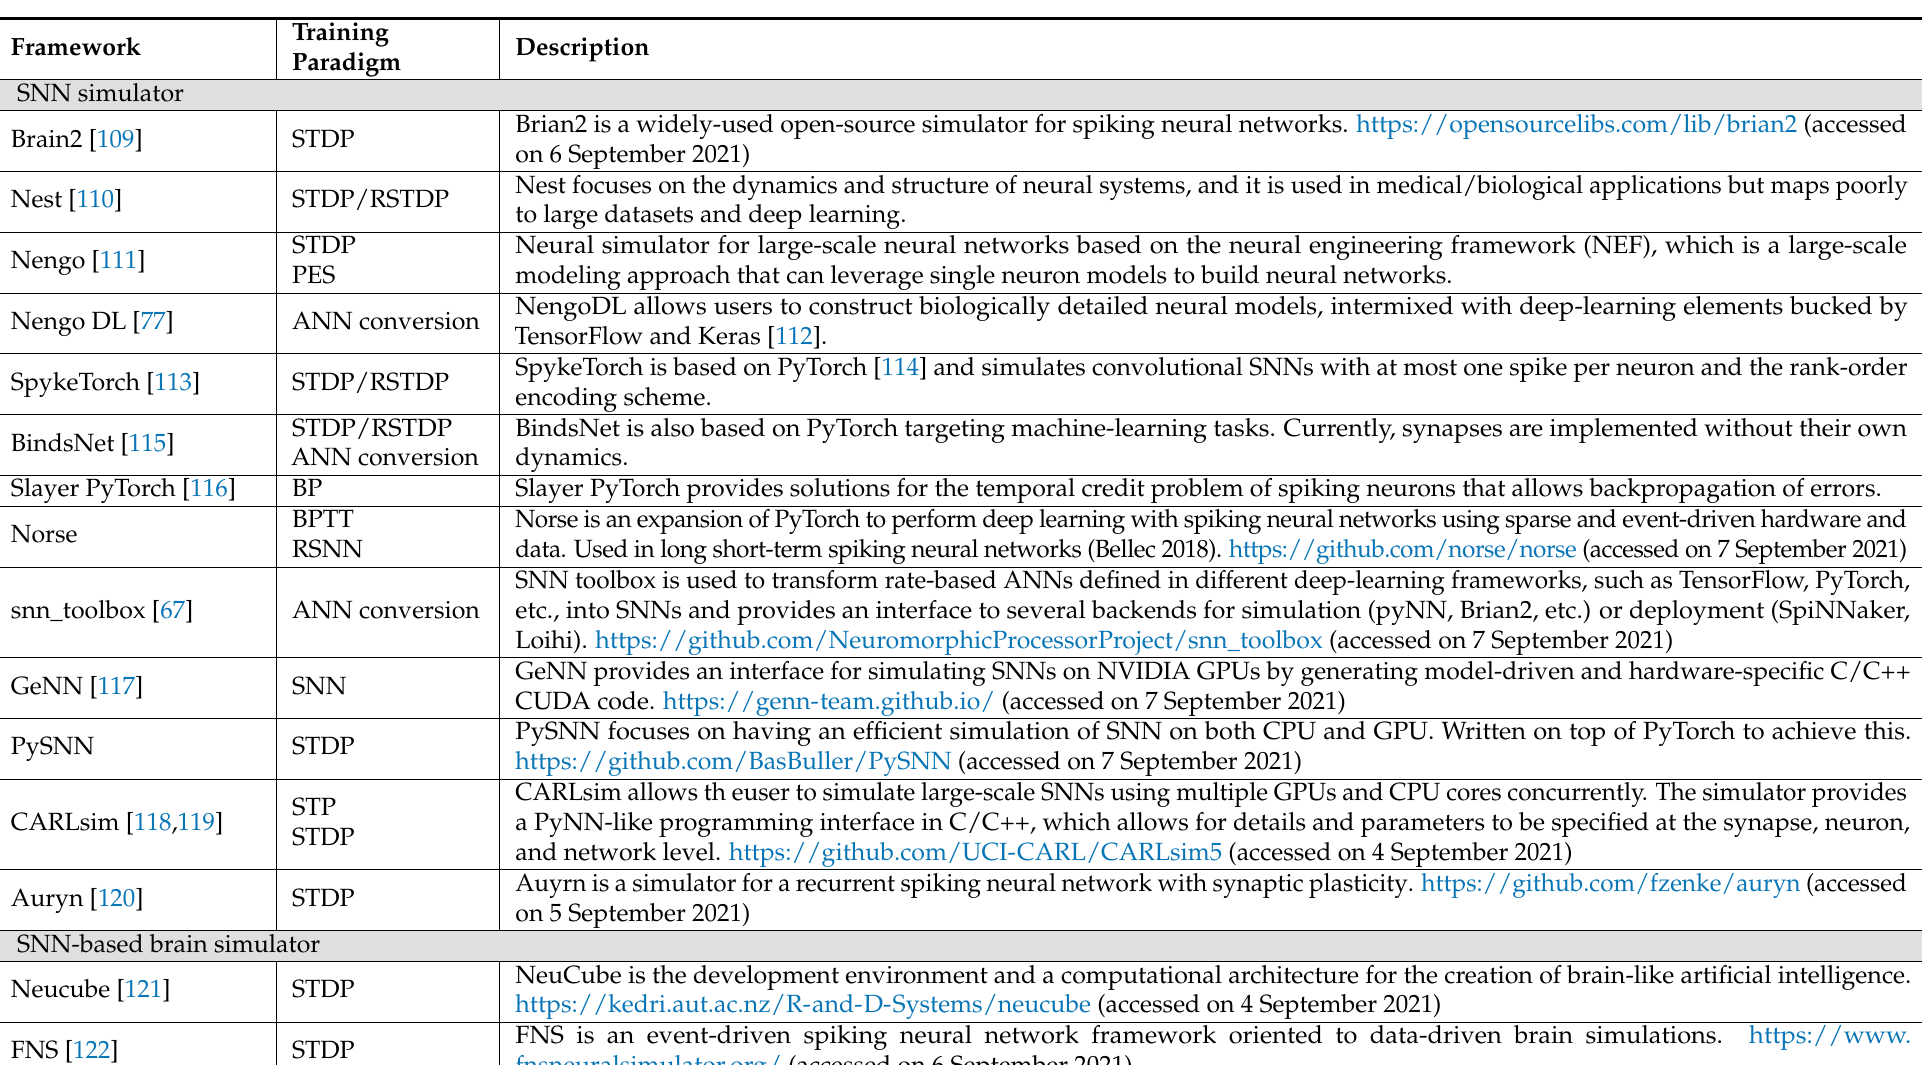
Table 4. List of available software frameworks for SNNs